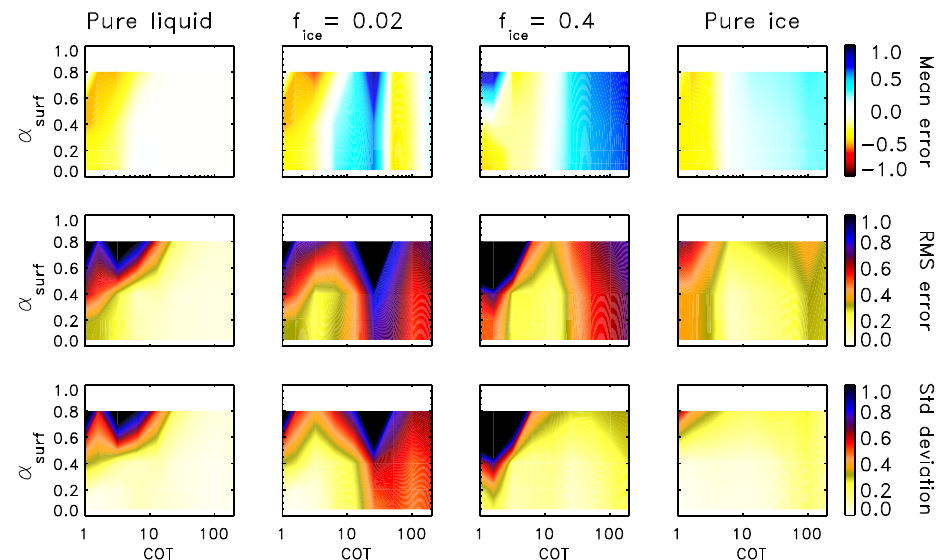
Fig. 5. The CWP retrieval errors as a function of COT and α surf , averaged over all satellite viewing angles with θ < 72 ◦ and solar zenith angles with θ 0 < 72 ◦ . The columns indicate different values of f ice , while the rows are as in Fig. 4. Again, effective radii are r eff = 11µm for liquid water clouds and r eff = 38µm for ice clouds.